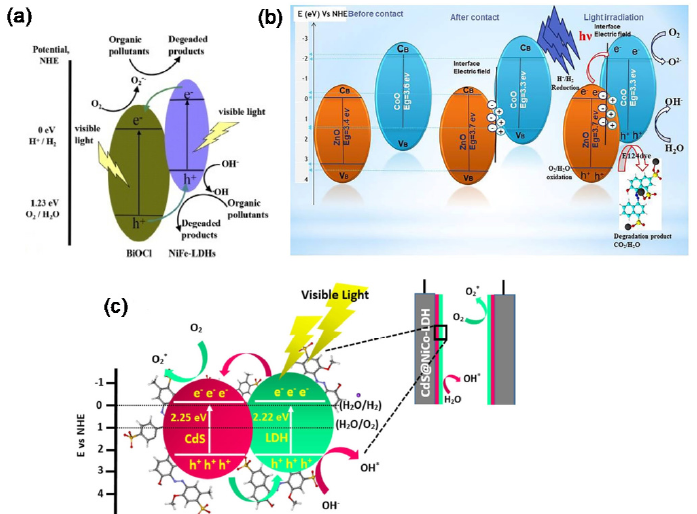
Figure 9. ( a ) The photocatalytic mechanism of BiOCl/NiFe − LDH heterostructure [108].